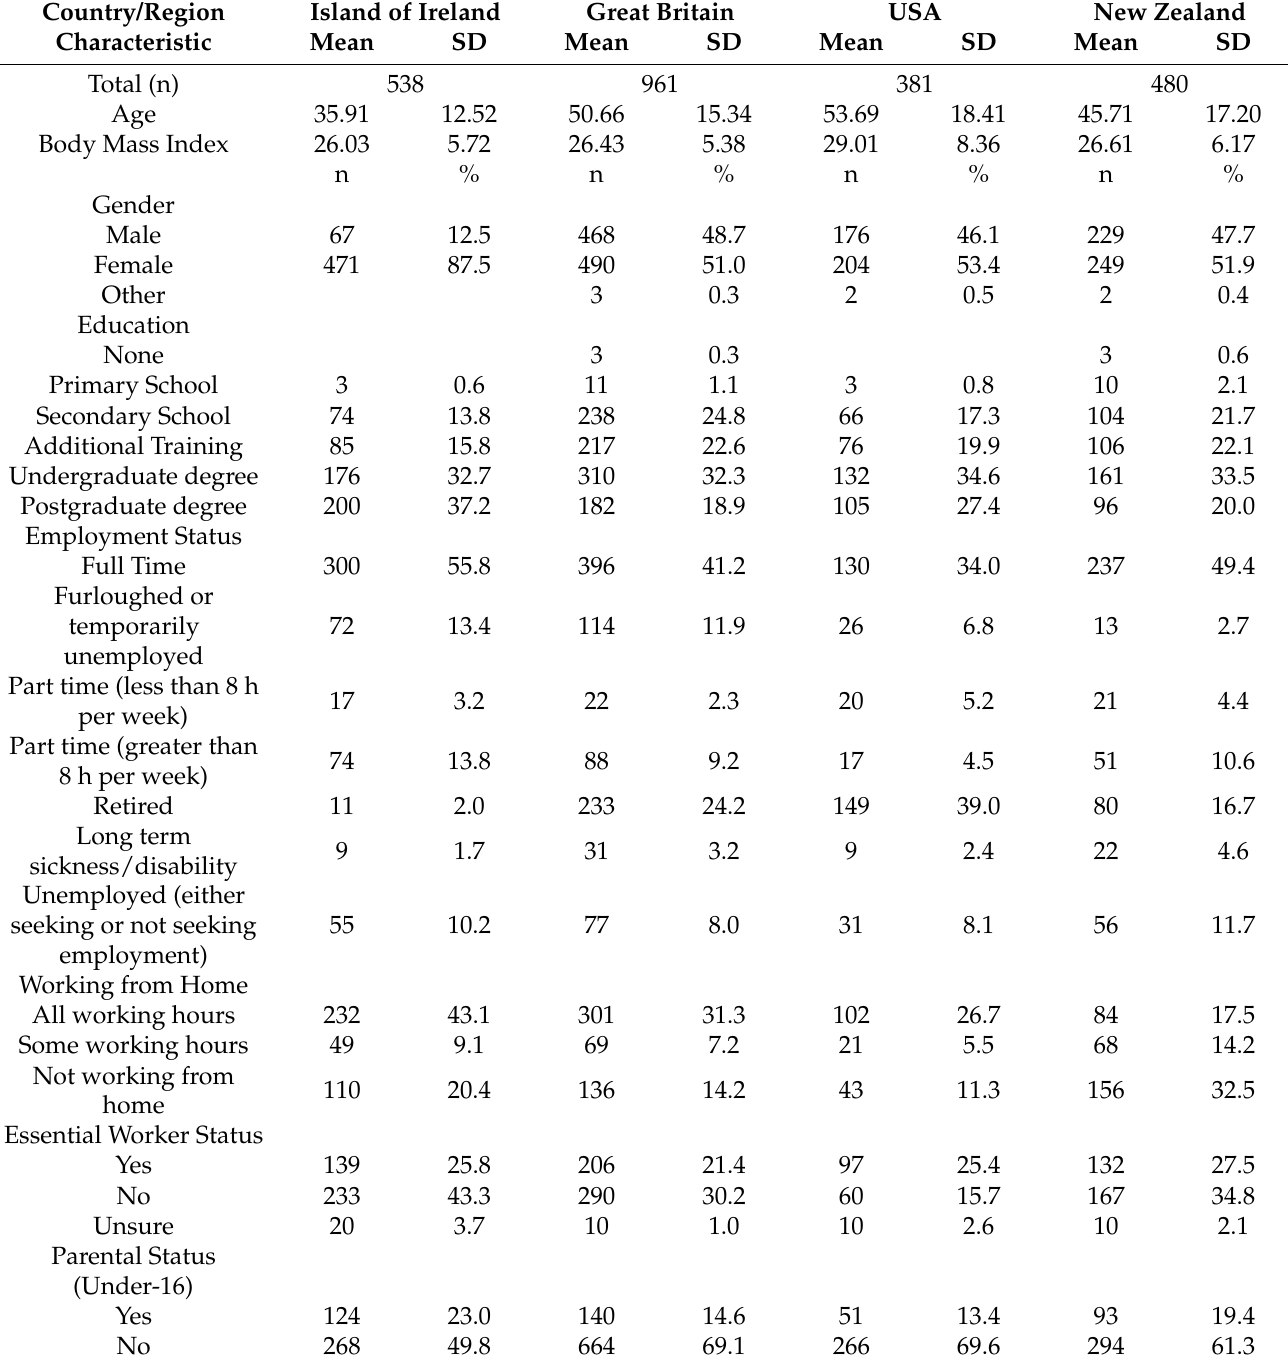
Table 1. Basic Demographics across the different